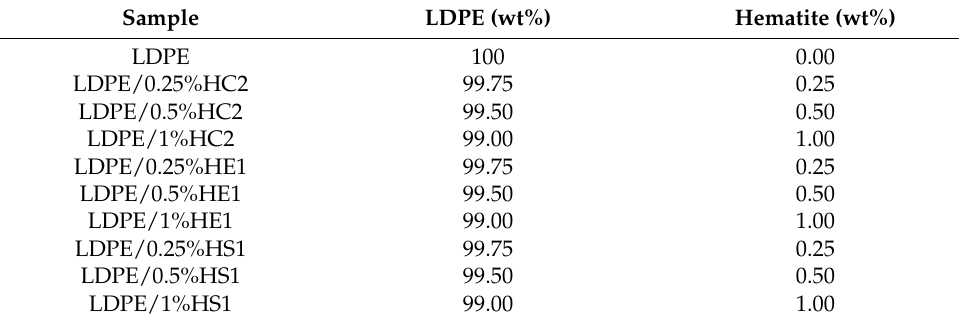
Table 1. Composition of prepared